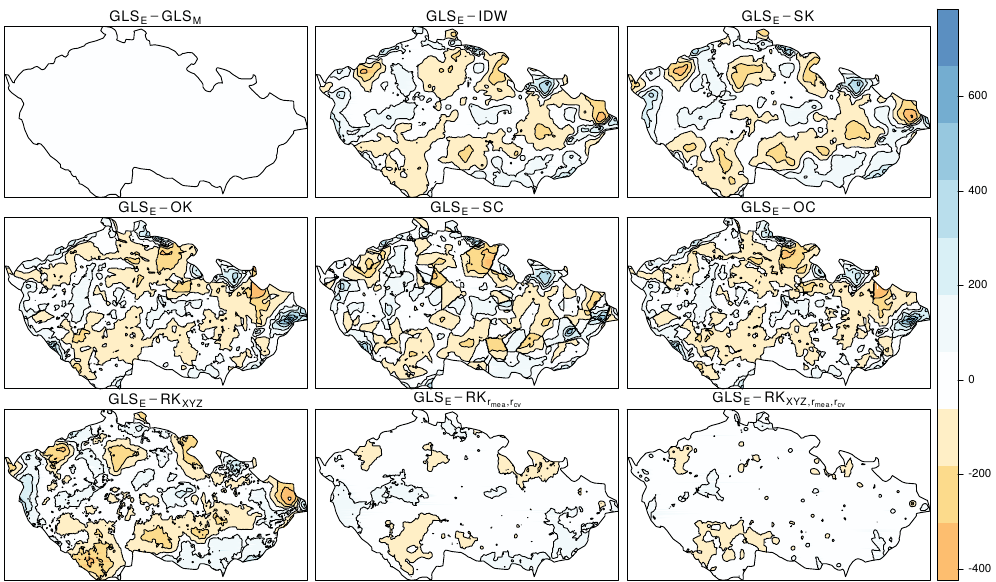
Figure 4. Differences (MJha − 1 mmh − 1 ) between the GLS E and other spatial interpolation models. GLS E – generalized linear model with exponential covariance structure; GLS M – generalized linear model with Matérn covariance structure; IDW – inverse distance weighting;